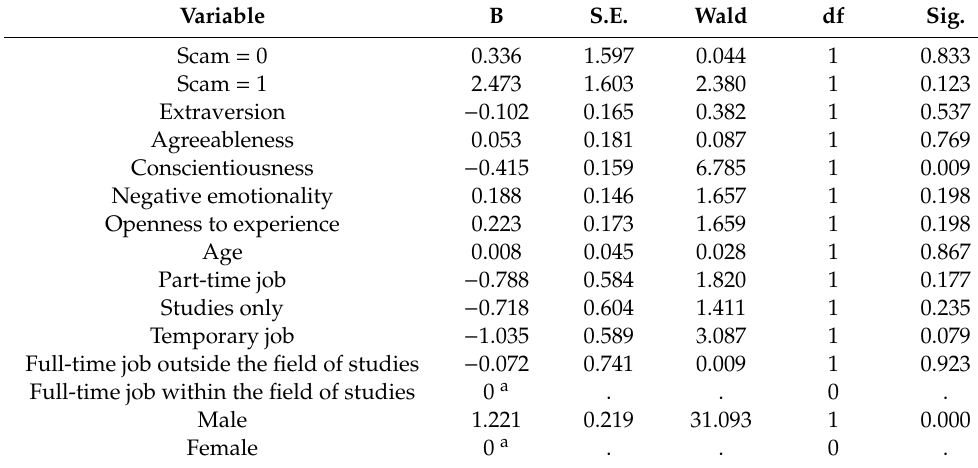
Table 7. Full Model 4—Scam: ordinal logistic regression.